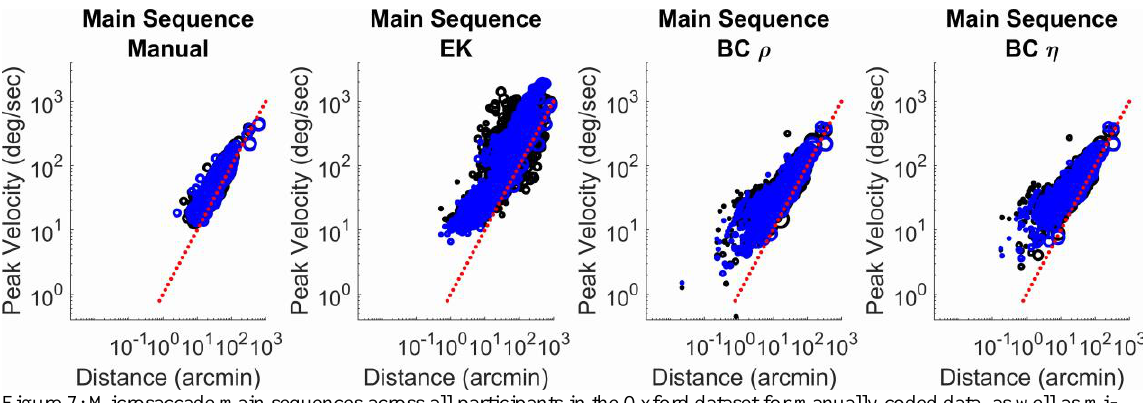
Figure 7: Microsaccade main sequences across all participants in the Oxford dataset for manually coded data, as well as mi- crosaccades identified using the EK and the BC methods. The blue circles represent microsaccade detected in the right eye, while the black circles represent microsaccade in the left eye. The area of each circle is scaled in relation to the number of samples in that microsaccade. The red line represents the unit